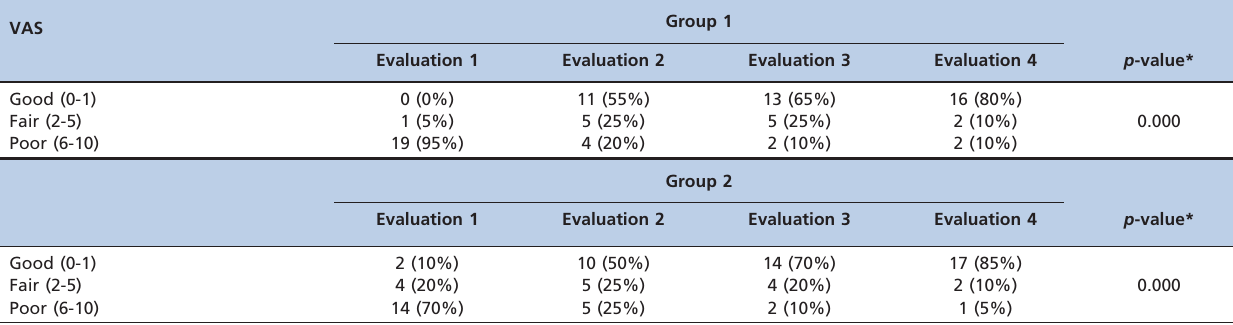
Table 2 - Distribution of intensity of morning pain in groups 1 and 2 before and after the treatment (immediately, three months and one year after the